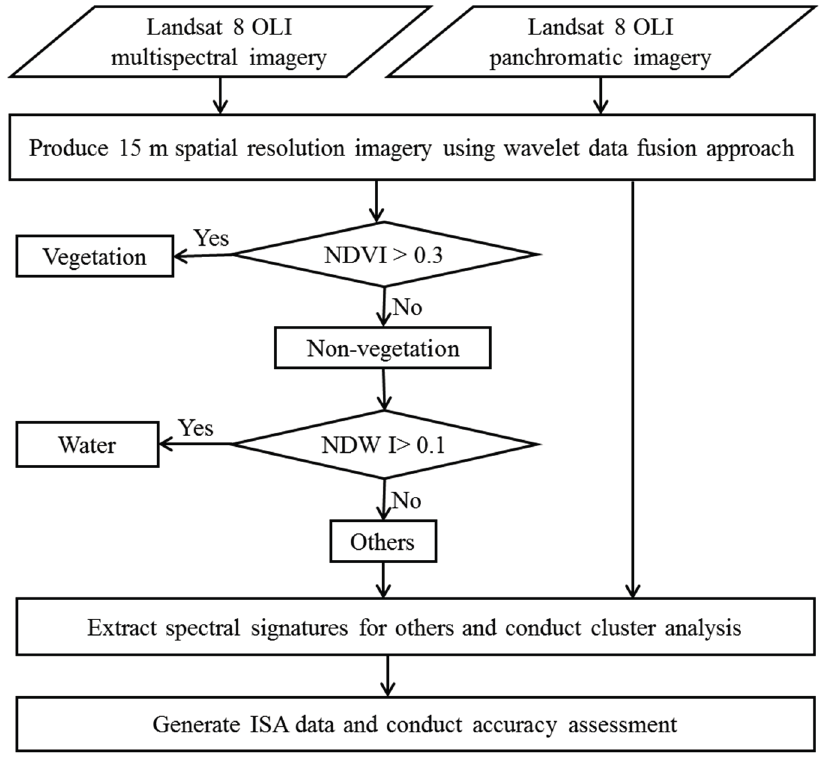
Figure 3. Framework of extracting ISA data from Landsat 8 OLI